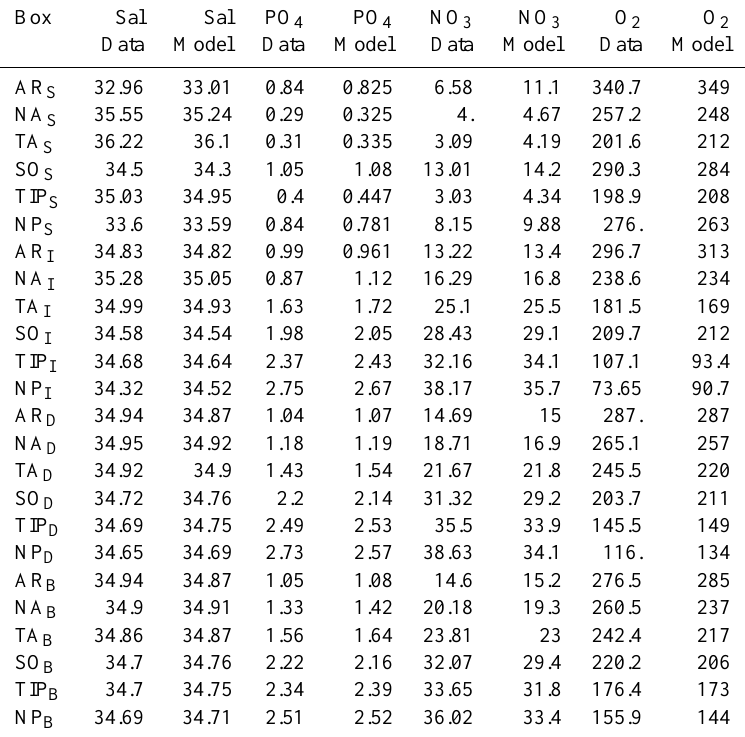
Table A1. Salinity (Sal in PSU), dissolved phosphate, nitrate, and oxygen in model boxes (in µM): Model vs. data. Subscripts: S: